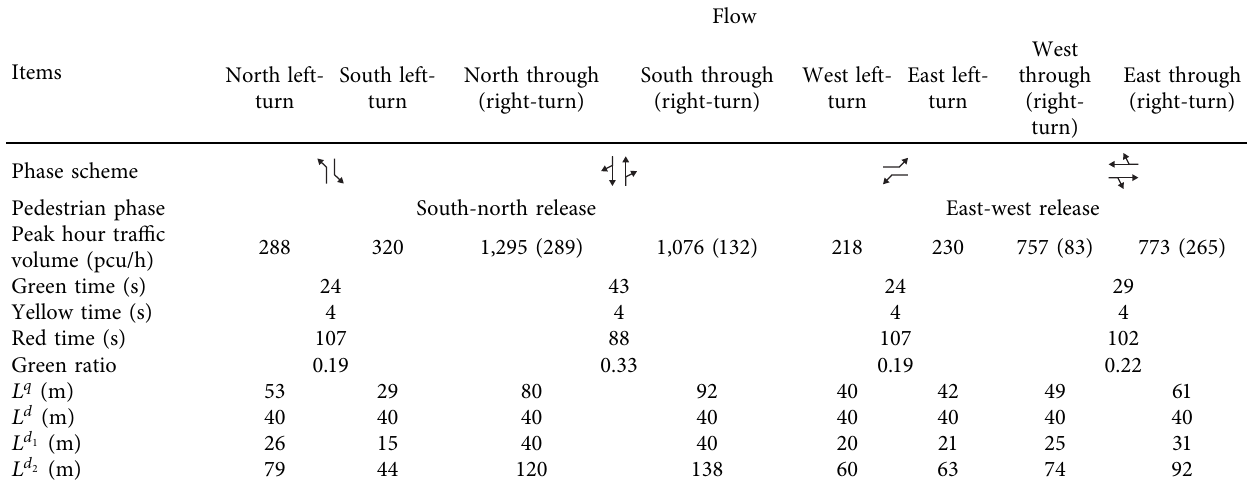
Table 2, the figures between the brackets represent the right- turn hourly traffic volume.